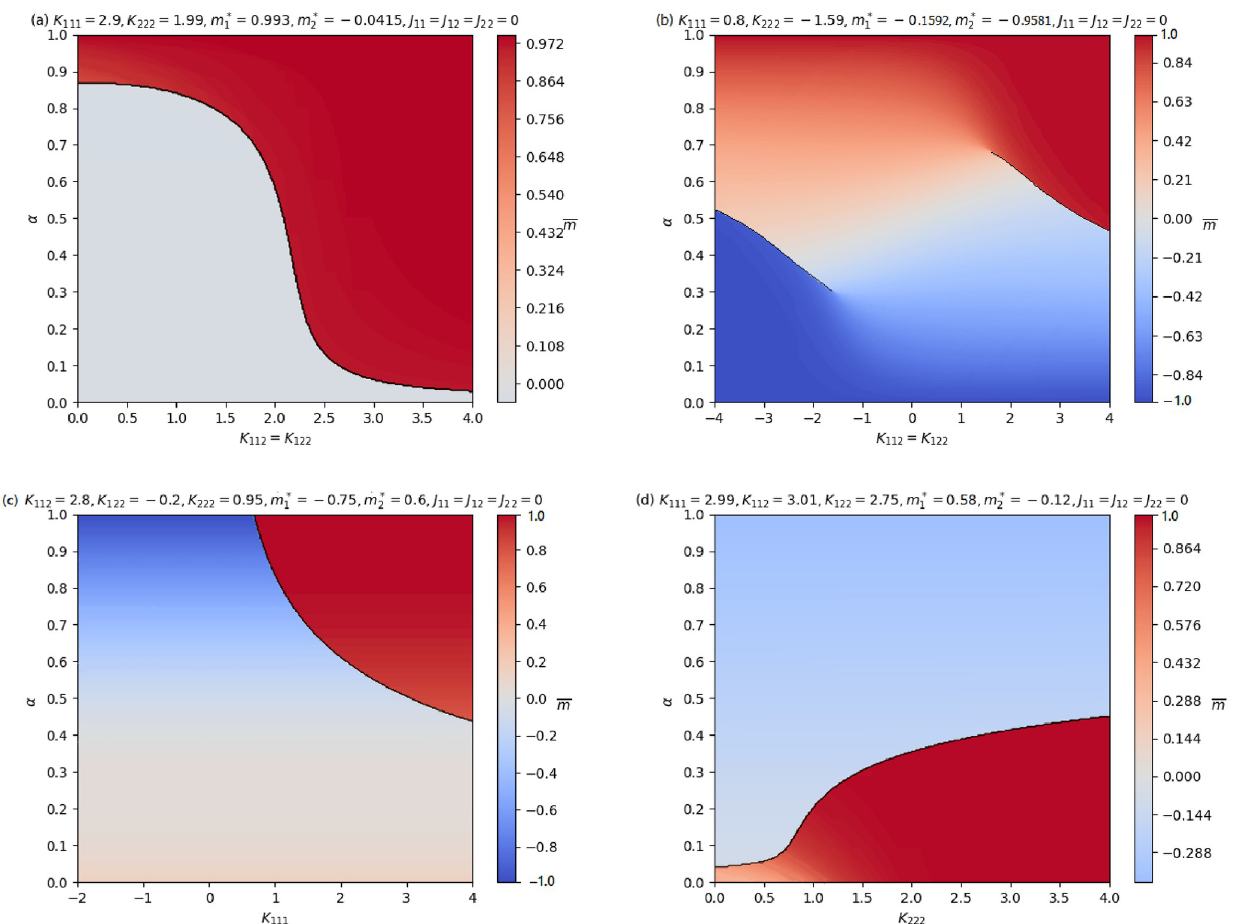
Fig 5. Phase diagram for fixed parameters of the cubic mean-field model. In panel (a) , when K 112 = K 122 is small the system require a larger fraction (i.e. α ) of the AI agents to observe a phase transition and as K 112 = K 122 increases, the proportion of AI agents required for a phase transition decreases. In this scenario, the relative fraction of the AI agents corresponding to the black line is a decreasing function of K 112 = K 122 . While panel (b) illustrate two separate jumps in the average opinion depending on the values of K 112 = K 122 and α . We observe from panel (c) that when interaction among AI agents ( K 111 ) increases their proportion needed to observe a phase transition decreases. While in panel (d) , when interaction among Human agents ( K 222 ) increases, the fraction of AI agents needed to effect a phase transition increases and vice versa.